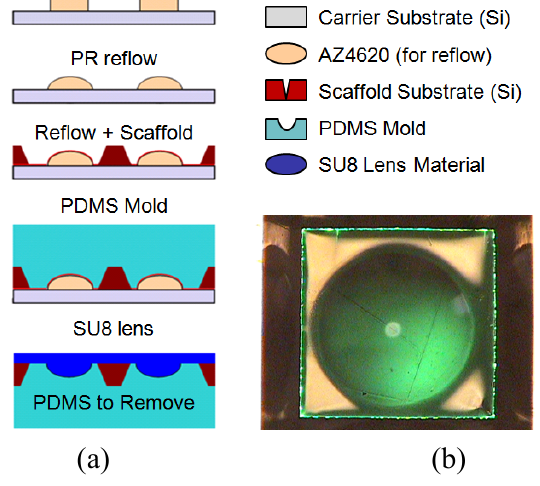
Figure 2. (a) Process flow of the microlens starts from photoresist reflow and is